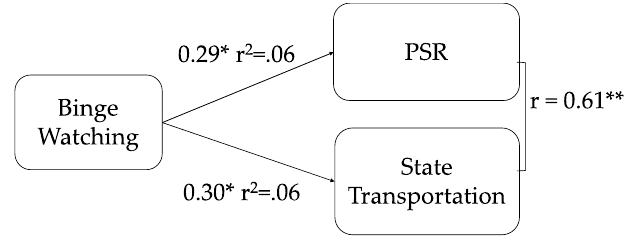
Figure 1. Model of the effect of condition on PSR and state transportation. * p < 0.05 ** p < 0.01.